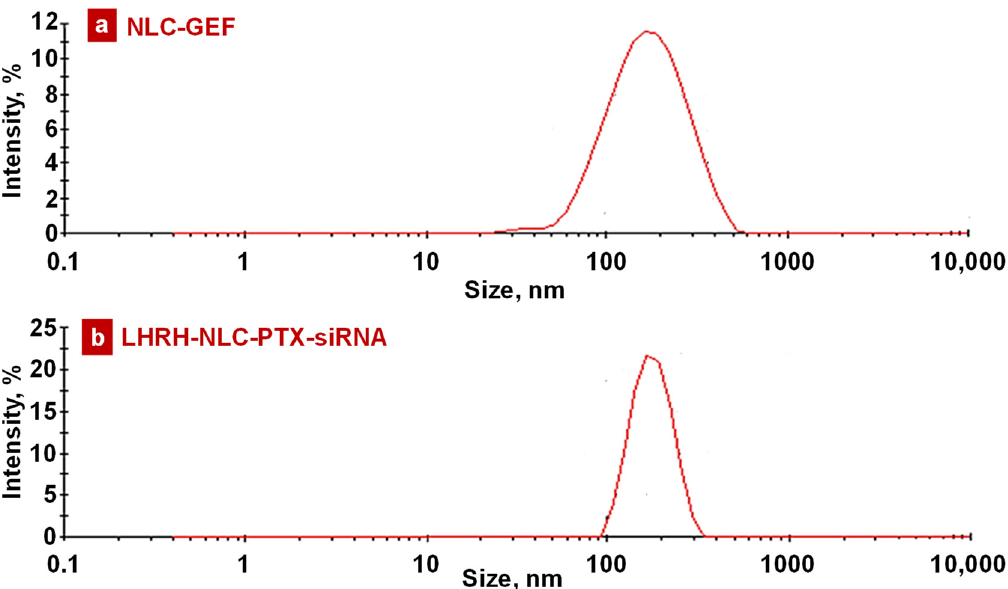
Figure 4. Representative histograms of intensity-size distribution of ( a ) NLC–GEF and ( b ) LHRH–NLC–PTX–siRNA.